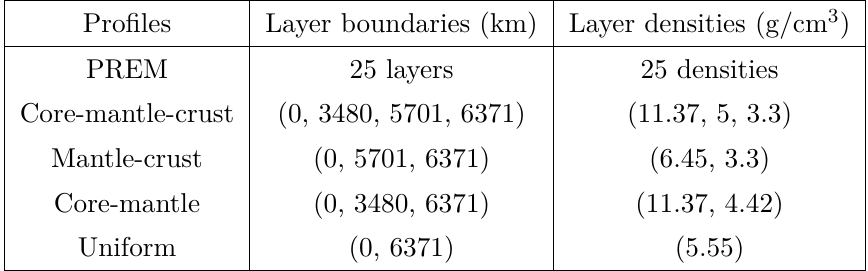
Table 1 . The boundaries and densities of layers for various profiles of Earth considered in this analysis. The radius and mass of Earth remain invariant for all these